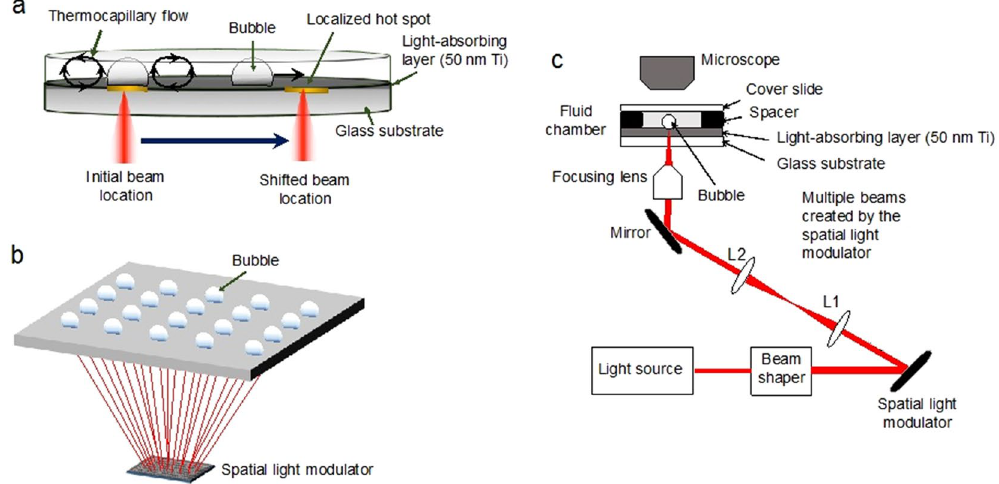
Figure 1. Opto-thermocapillary flow-addressed bubble (OFB) microrobots. ( a ) The OFB microrobots are gas microbubbles that are generated by the laser heating of a light-absorbing layer on the substrate. Thermocapillary forces created by the laser-generated temperature gradient are used to actuate the bubble microrobots. ( b ) A simplified schematic showing that a single laser beam can be shaped using a spatial light modulator, creating dynamic optical patterns that enable the simultaneous control of multiple OFB microrobots. ( c ) Experimental setup for the OFB microrobot